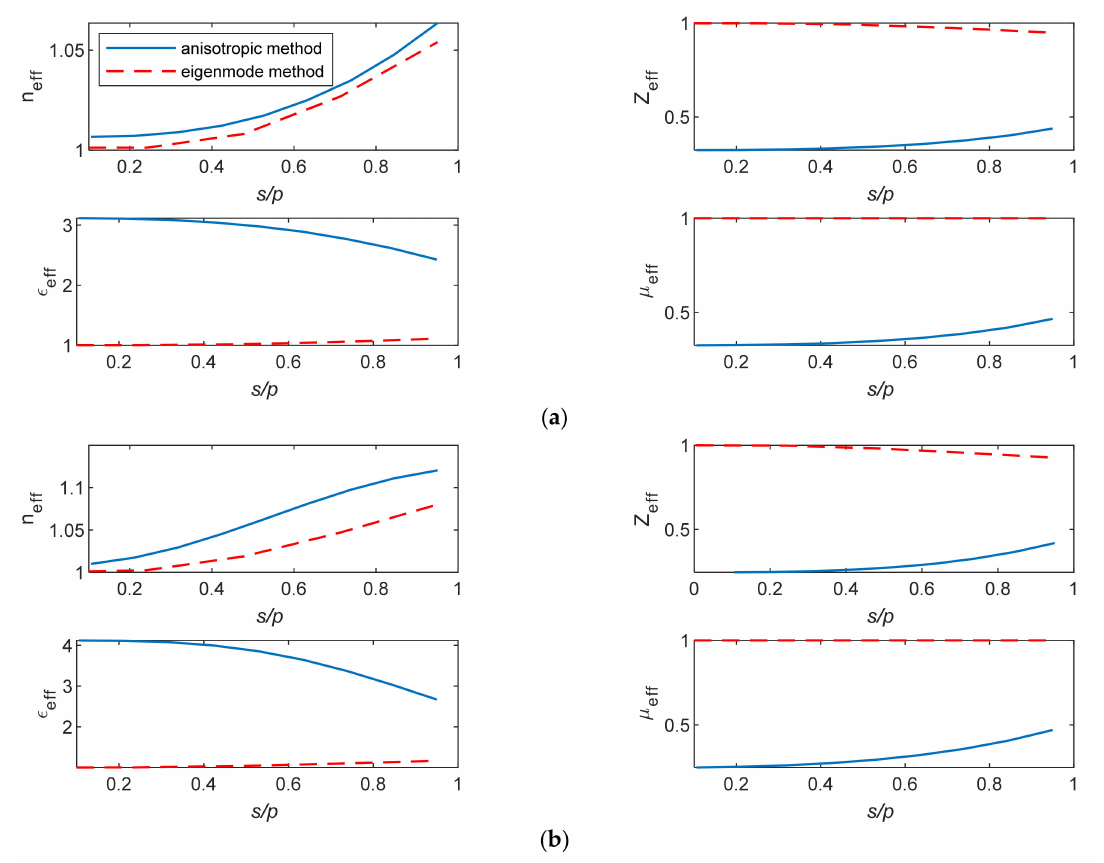
Figure 8. The extracted EM parameters of ( a ) holy and ( b ) holy glide-symmetric unit